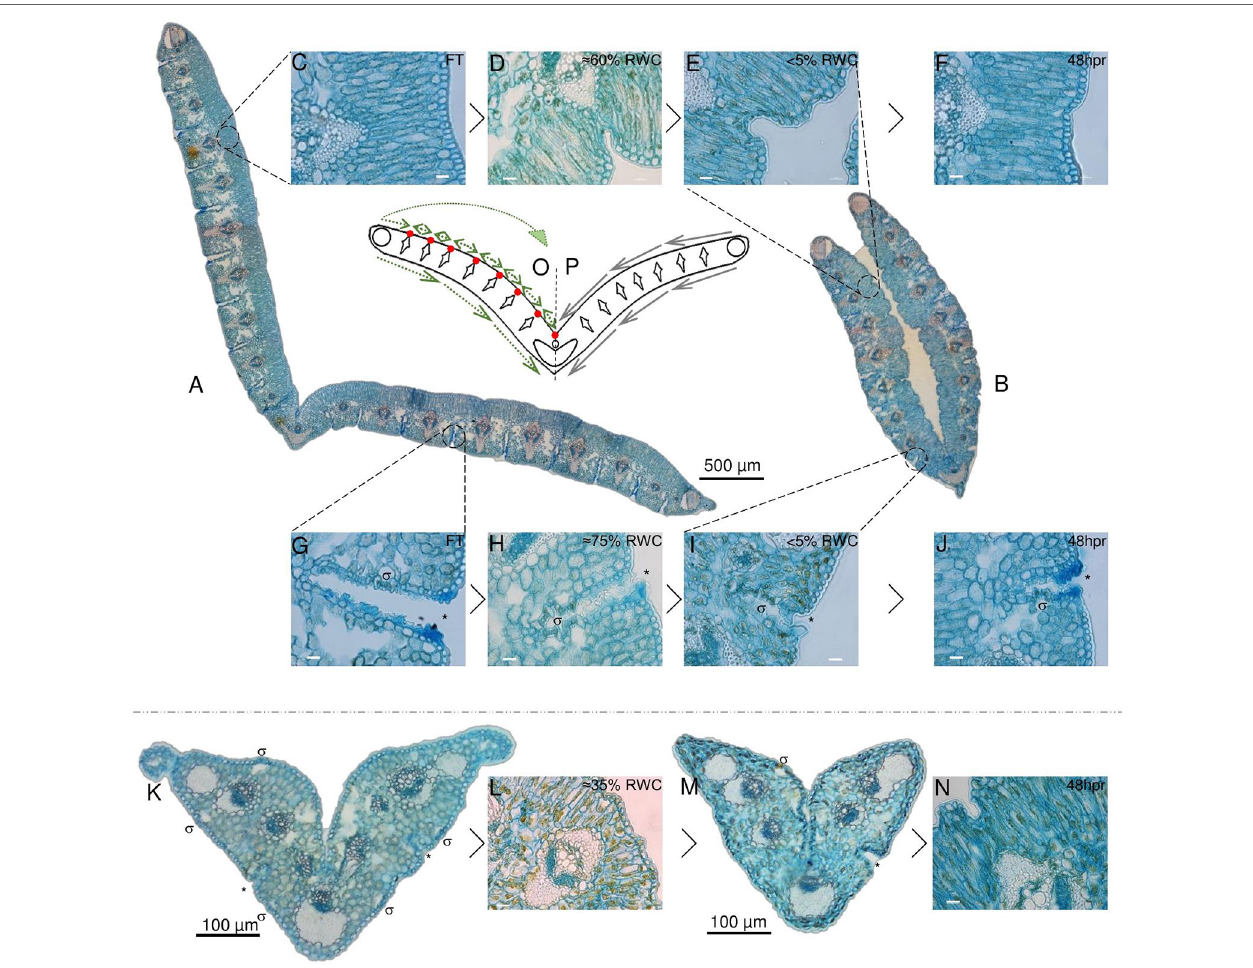
FigURe 3 | Desiccation associated tissue modifications in non-senescent tissues (NST) and ST. Typical cross section of a full turgor [≈100% relative water content (RWC); FT] blade is shown in (A) with while a cross section at 5% RWC is shown in (B) . The abaxial surface in A is open to the environment, while this same surface becomes enclosed due to folding about the midrib in (B) . Modifications to the adaxial palisade mesophyll during desiccation and at 48 h post-rehydration (48 hpr) is shown in (C – F) with %RWC indicated. Modifications to abaxial stomatal channels is shown in (g – J) . Stomata (σ) lay in deep channels (*) (g – J) that become increasingly closed and mucilage-rich (h, i) with water deficit stress. ST is shown in (K – N) . Stomatal channels appear not to close as efficiently (M) and there appears to be a greater degree of Procion yellow staining, indicating a higher degree of cellular constituent aggregation. (O, P) represent a simplified model of the typical leaf blade in cross section with all collections of sclerenchyma indicated. (P) displays the theoretical mechanical forces experienced by the tissues at water loss, while (O) displays a hypothesized means by which points of palisade compaction allow for redirection of these forces to provide the observed transition from (A – B) . Scale bars for (C – J, L , and N) are 10 µm, rest are as